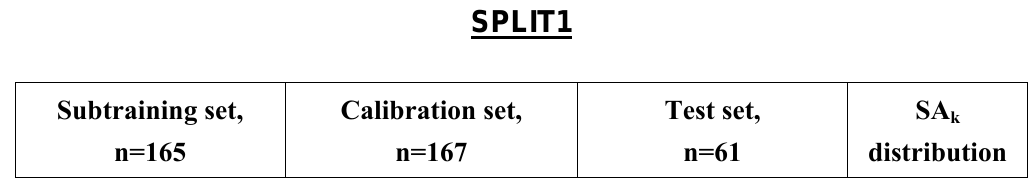
Table 4. Average statistical characteristics of the QSAR model of carcinogenicity (logTD ) for three splits into the subtraining, calibration, and test sets with the limS values 50 of 0-10. For the best models three attempts of the Monte Carlo optimization together with average values are presented, for other models only average values are